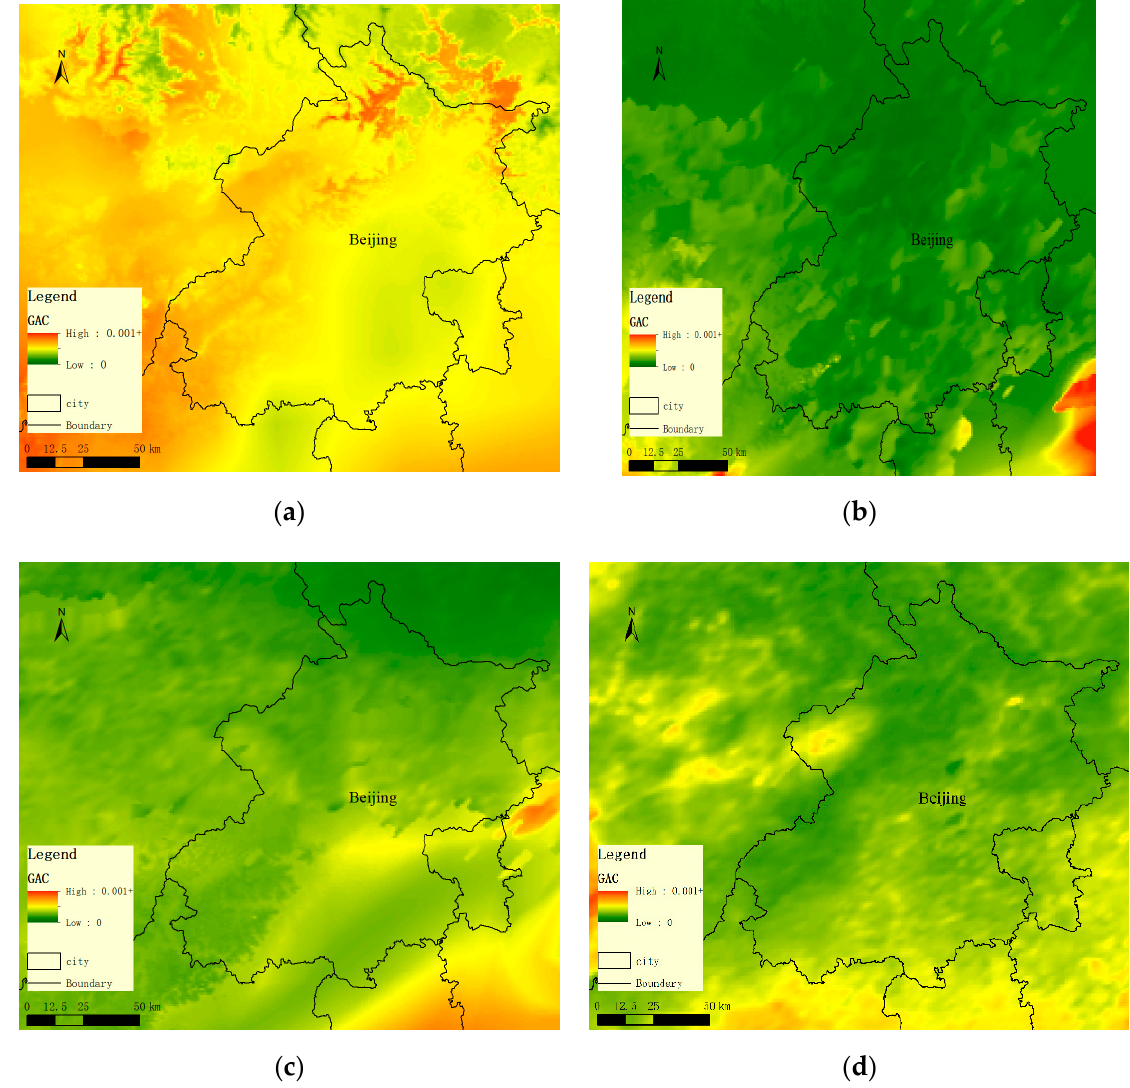
Figure 14. Spatial distributions for four seasonal days in Beijing: a spring day (1 April 2015) ( a ), a summer day (1 July 2016) ( b ), an autumn day (1 October 2017) ( c ) and a winter day (30 December 2018) ( d ).